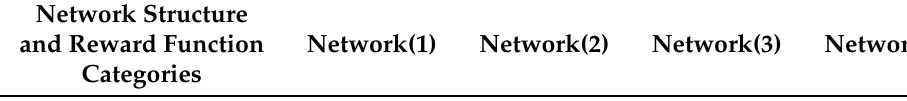
Figure 10. Under the reward function(4), the efficient distances between RTD3 (red) and TD3 (blue) for four times of randomly initialized network node parameters under the same initial network node conditions as shown above in ( a – d ). Table 9. Under four reward function settings, the variances of efficient distances of RTD3 and TD3 for four times of randomly initialized network node parameters when episode varies from 30,000 to